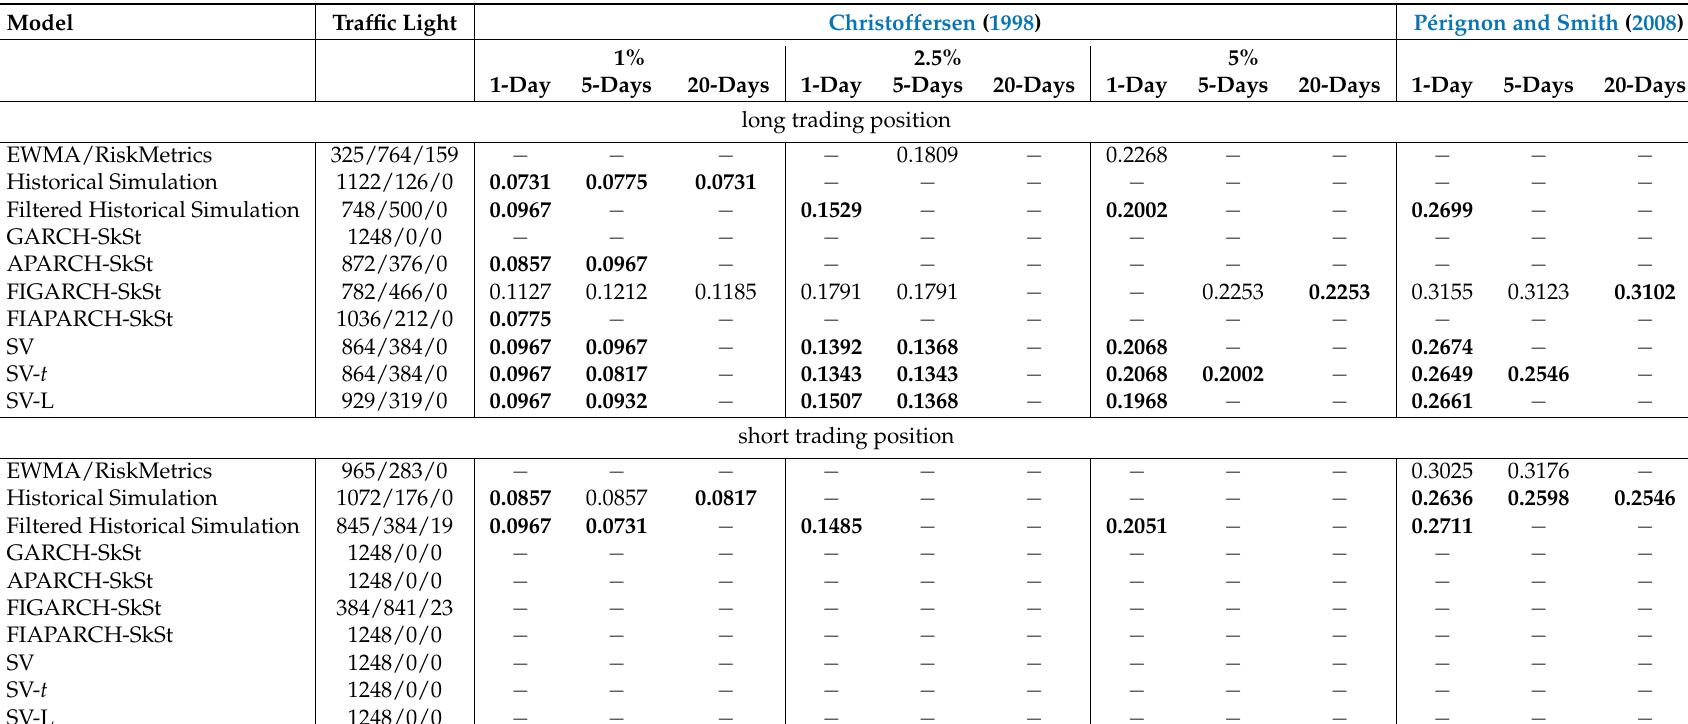
Table 7. Value-at-Risk backtest results for VNI